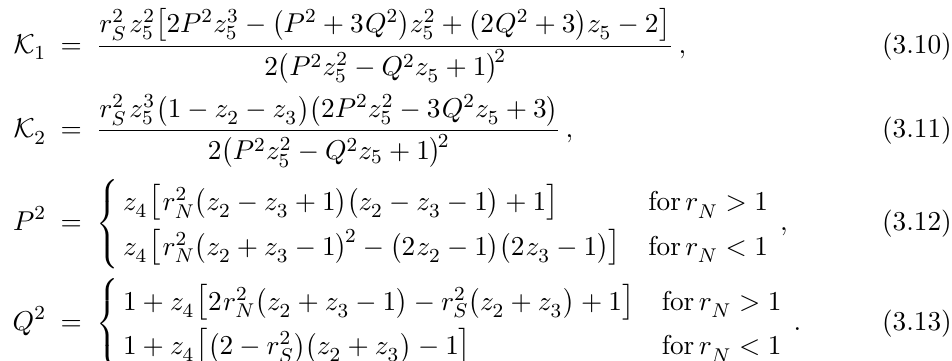
Figure 3 . One-loop function I as a function of r I ∼ O (0 . 1 − 1) in the DM mass range of